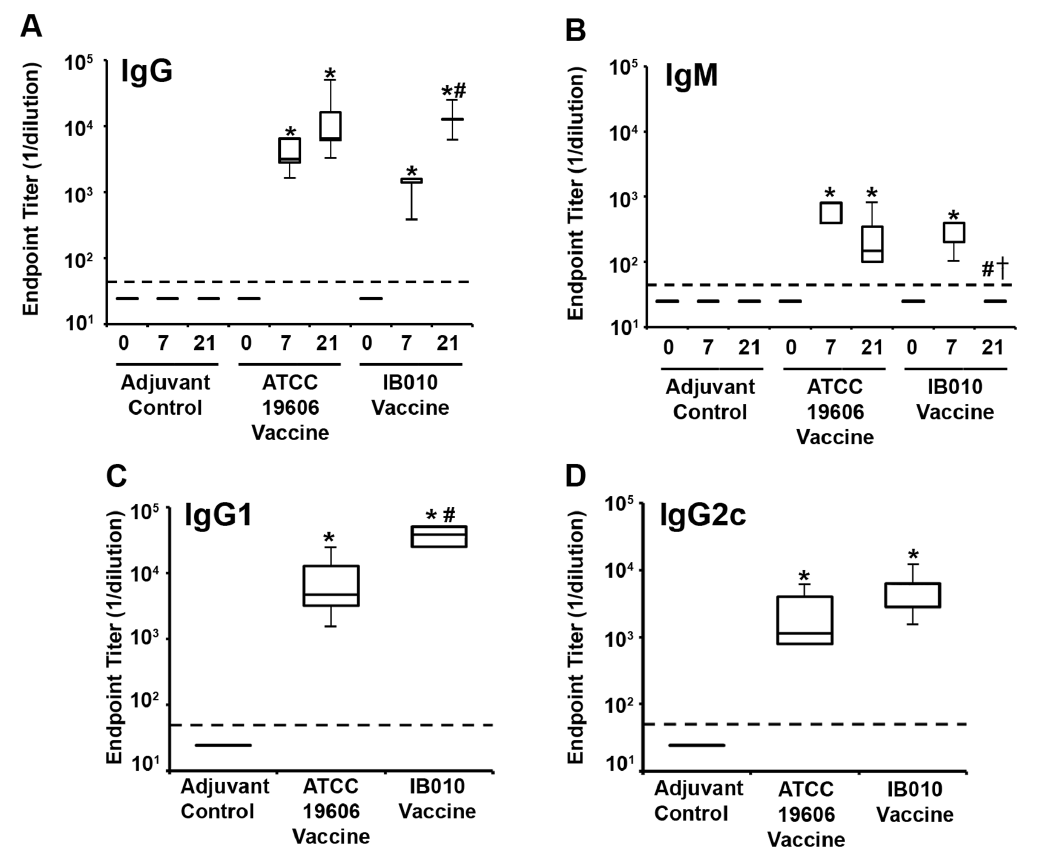
Figure 2. Antibody response to immunization with IB010. Serum samples were collected from ATCC 19606 vaccinated, IB010 vaccinated and control mice before vaccination (Day 0) and at day 7 and 21 after the first immunization, and levels of antigen specific total IgG (A) and IgM (B) were measured by ELISA (n 5 8 mice/group). IgG1 (C) and IgG2c (D) levels in serum collected 7 days after the second immunization were determined in serum were measured by ELISA in ATCC 19606 vaccinated, IB010 vaccinated and control mice In all panels box and whisker plots represent the interquartile ranges and ranges, respectively, and horizontal lines represent median values. * p , 0.05 compared to levels in control mice at the same time point, # p , 0.05 compared to 7-day samples from the same experimental group, { p , 0.05 compared to 21-day samples in ATCC 19606 vaccinated mice.